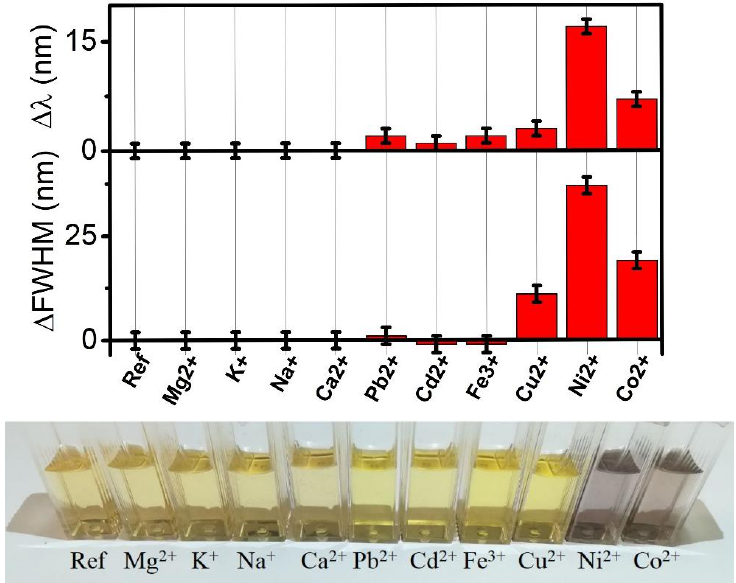
Figure 2. Δλ and ΔFWHM of the AgNPs-3MPS solution with 1 ppm of different metal ions. Image of Figure 2. ∆ λ and ∆ FWHM of the AgNPs-3MPS solution with 1 ppm of different metal ions. Image of the colorimetric aspect of 1.0 ppm solution of different ions. the colorimetric aspect of 1.0 ppm solution of different ions.